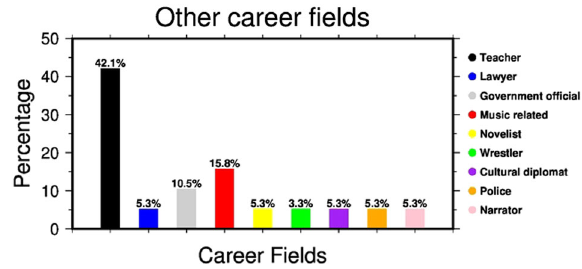
Fig. 2 Desired future career – other fi elds. Breakdown of other fi elds selected by the students (according to percentage).